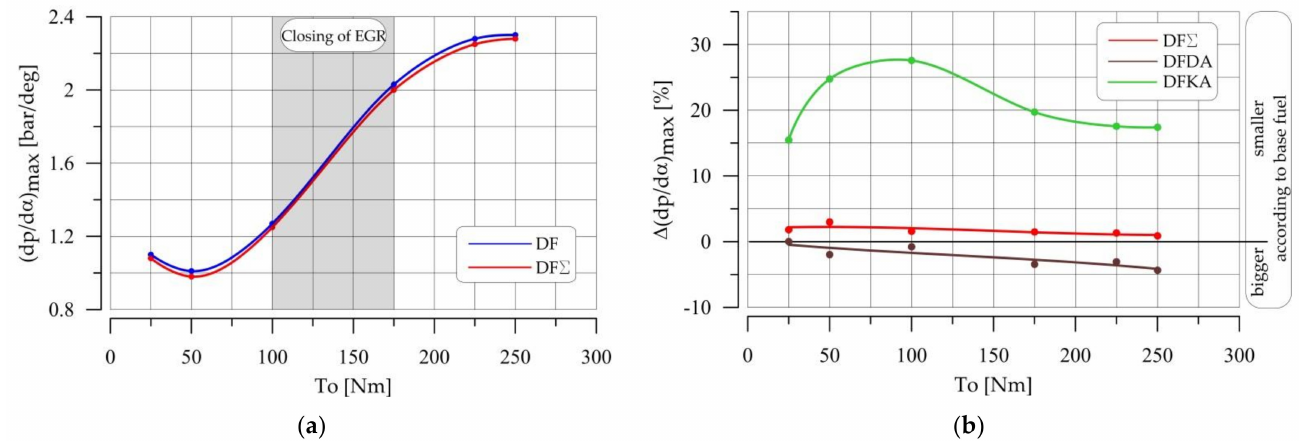
Figure 18. ( a ) Maximum pressure increase rate in the cylinder vs. engine torque; ( b ) Percentage difference of the maximum pressure increase rate in the cylinder vs. engine torque in relation to the base fuel.